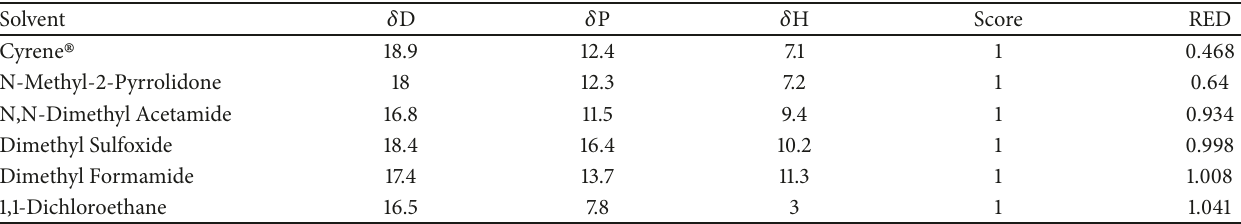
Table 1: Hansen Solubility Parameters [MPa 0.5 ] of different solvents and RED calculated for PES polymer.